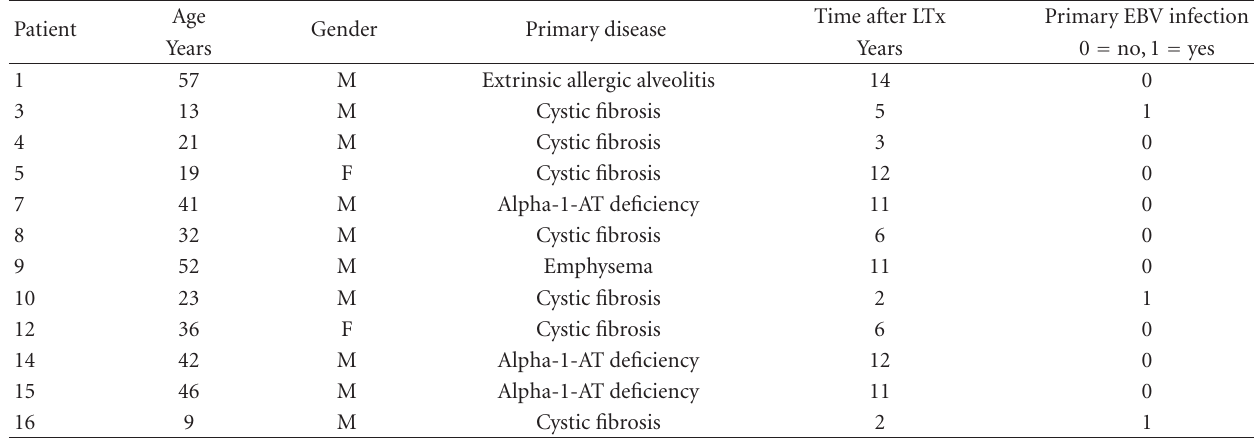
Table 1: SOT patients with chronic high viral load. Primary infection after transplantation is indicated.